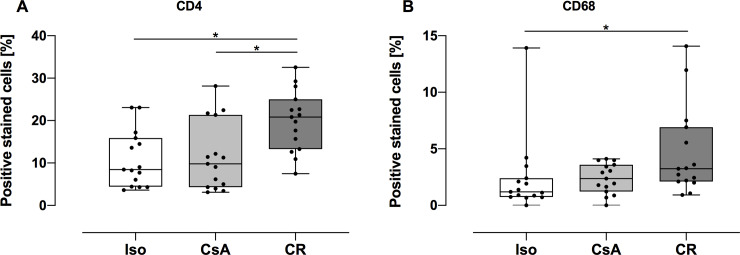
CD4 and CD68 positive stained cells in muscle tissue at POD 100.Data is presented as individual data points and boxplots; boxplots show the median, 25%- and 75%-quartile; whiskers indicate the minimum and maximum. Number of CD4 positive cells was significantly elevated in CR group in comparison to Iso and CsA groups. Count of CD68-positive stained cells revealed significantly higher cell count in CR group in comparison to the Iso muscle (*: p < 0.05).